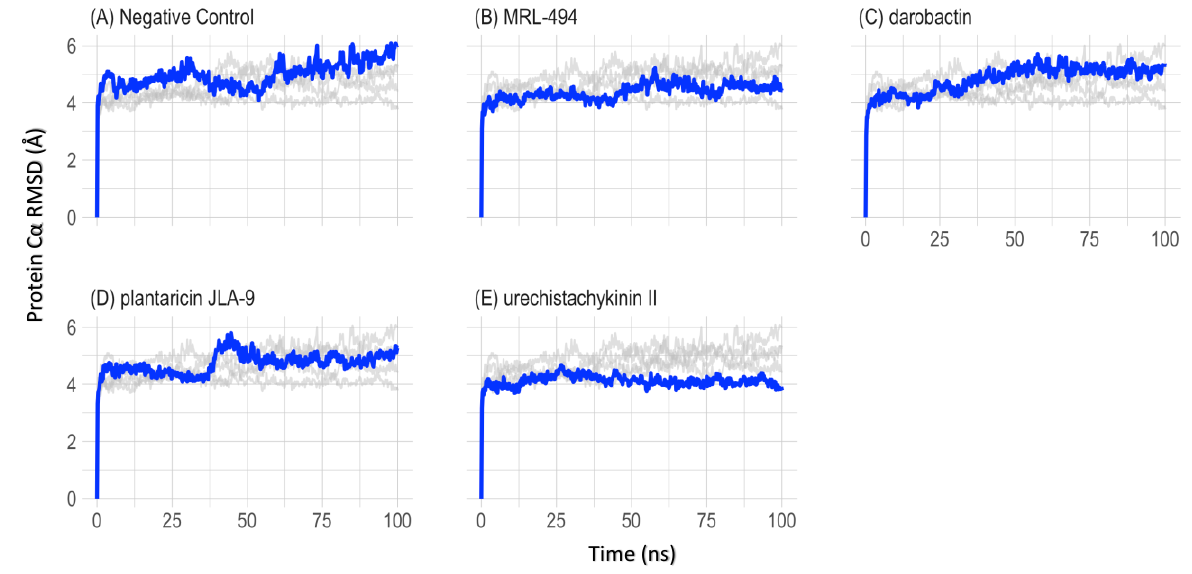
Figure 4. C α RMSD for the 100 ns MD of the efflux pump complex. The main data for each graph are marked in blue, and the other four sets of data used as comparisons are marked in gray. The RMSD of all the simulated complexes of C α was stable between 50 to 100 ns.